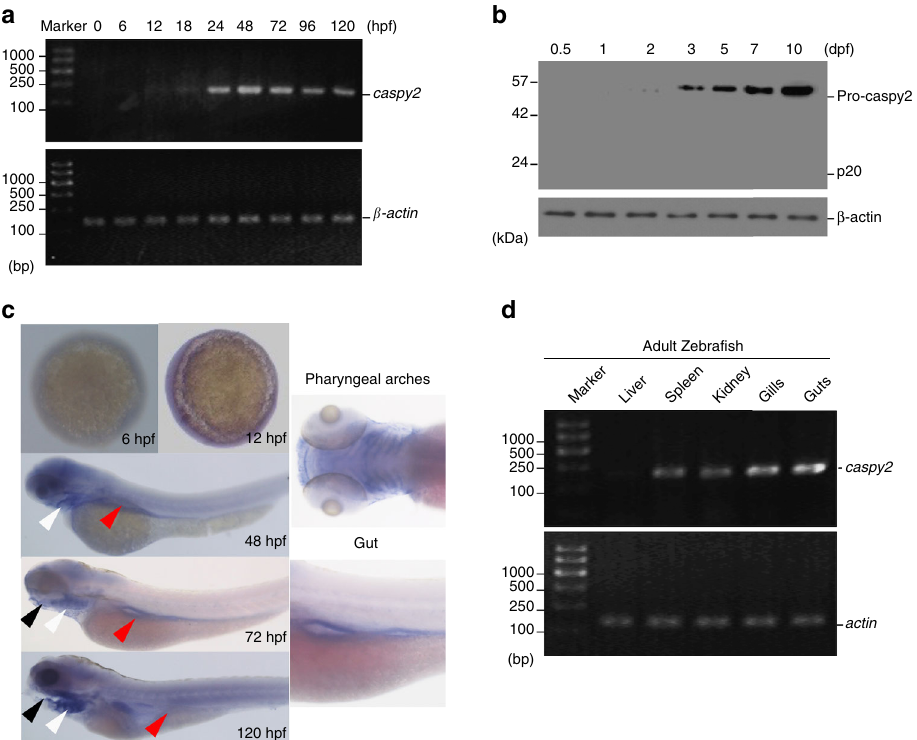
Fig. 5 Pattern of caspy2 expression in zebra fi sh. a Reverse transcription polymerase chain reaction (RT-PCR) analysis of relative caspy2 expression at various stages of development. b Immunoblotting analysis of caspy2 levels at various stages of whole larvae development. c Whole-mount in situ hybridization targeting caspy2 mRNA in zebra fi sh at the developmental stages indicated. Black arrowheads, mouth; white arrowheads, pharyngeal arches; red arrowheads, gut. d RT-PCR analysis of relative caspy2 expression in the indicated adult zebra fi sh organs. a – d Results are representative of at least three independent